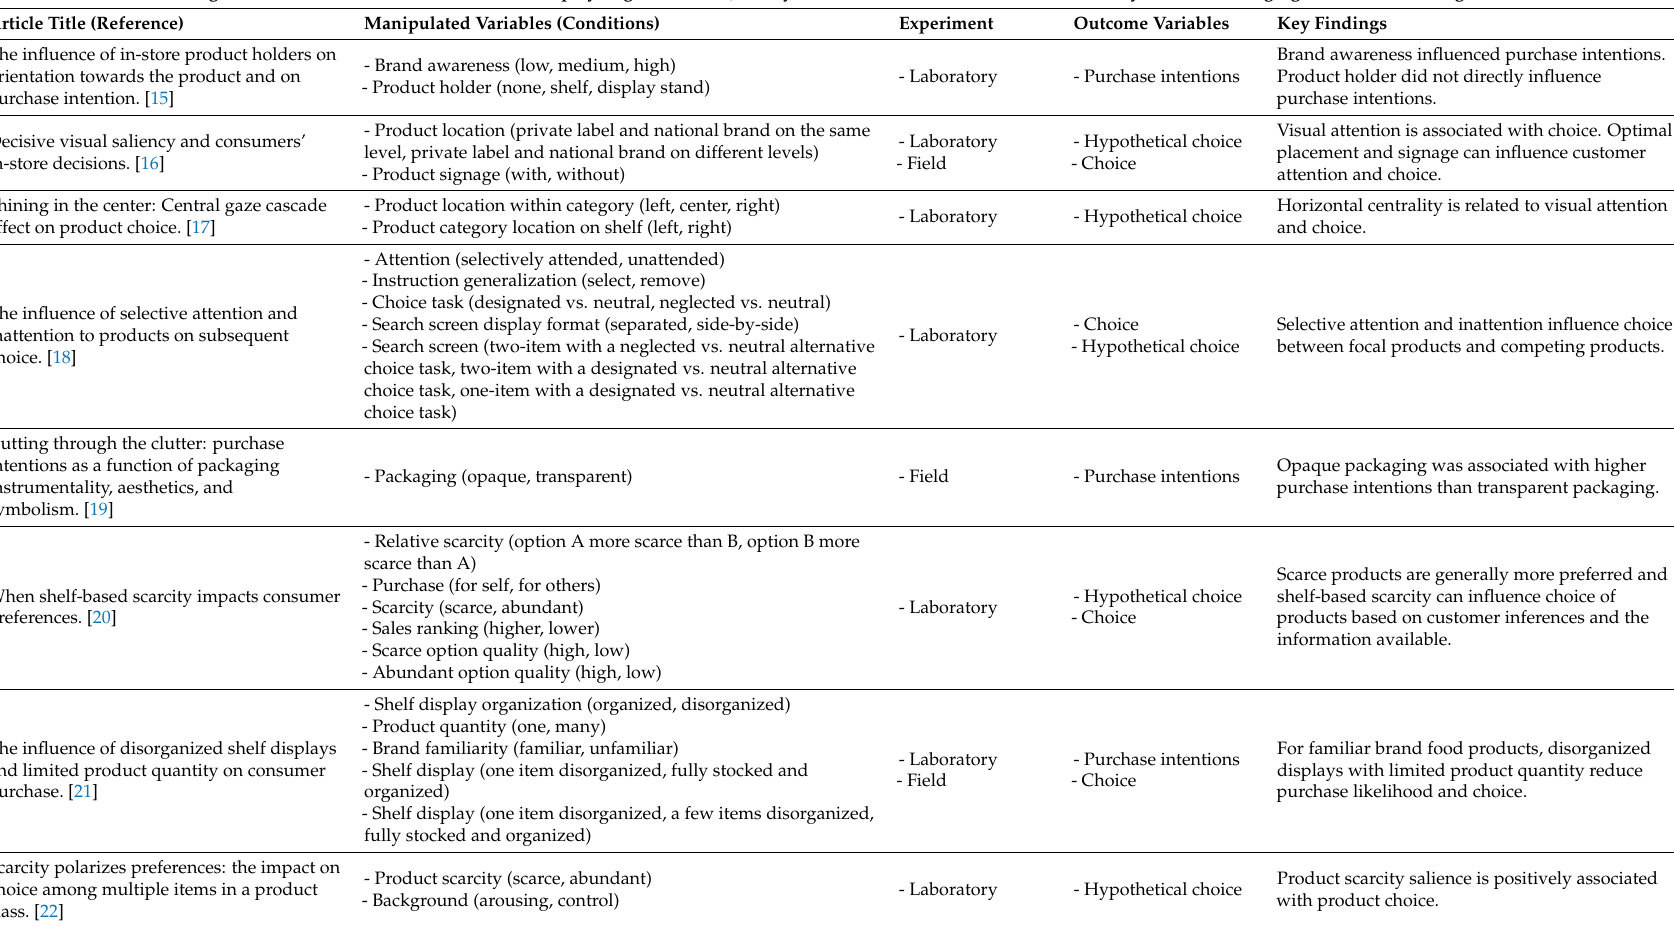
Table 2. Summary of